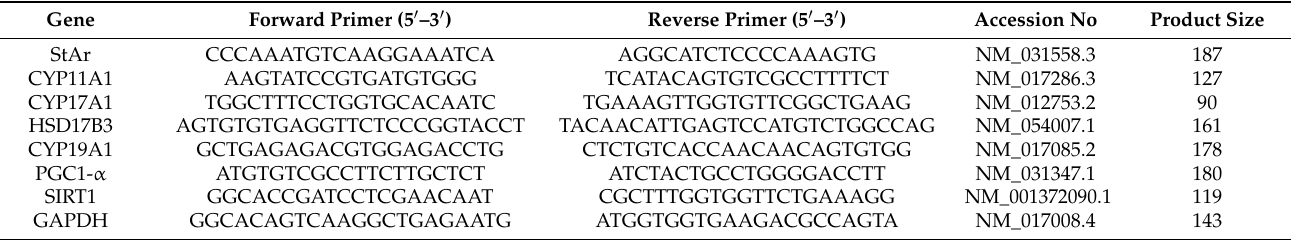
Table 1. Primer sequences, accession number, and product size for the quantitative RT-PCR for the analyzed genes in the testicular